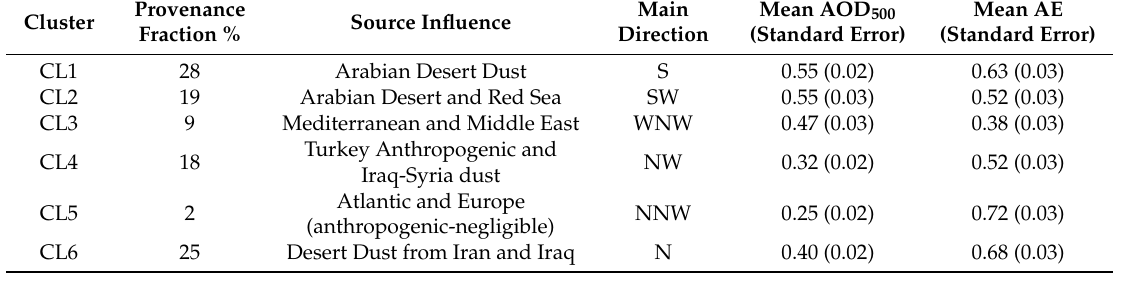
Table 2. Mean AOD 500 and AE values per trajectory cluster, along with their standard deviations.